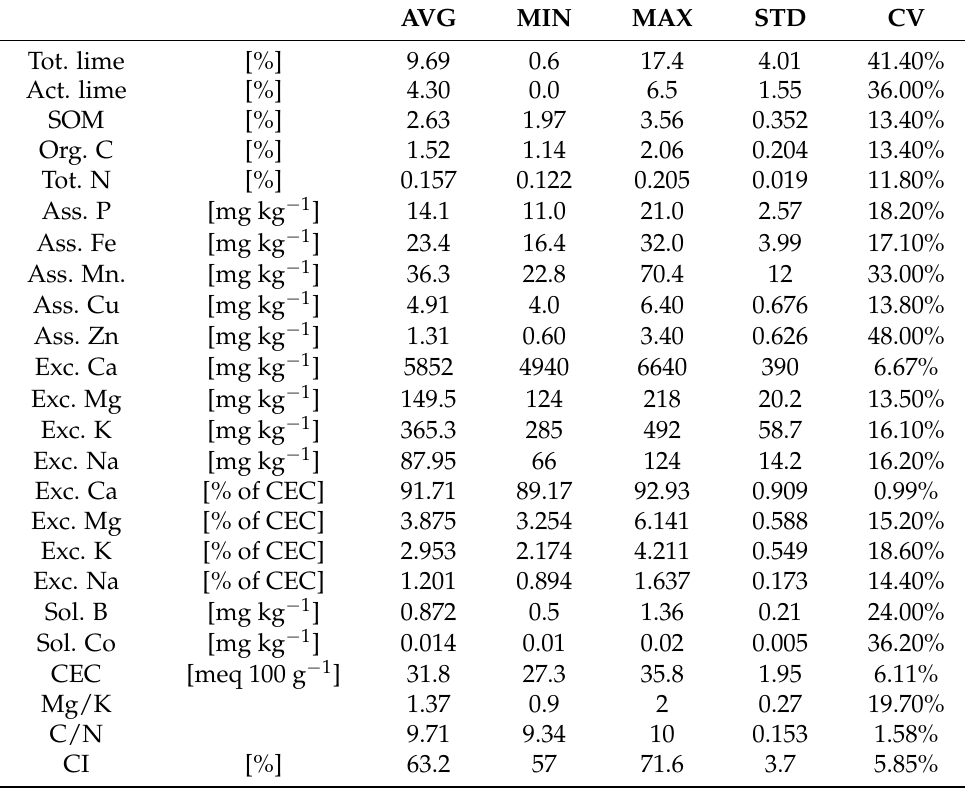
Table 3. Descriptive statistics for soil chemical properties on sampling point set. See Tables 1 and 2 for abbreviations and units of